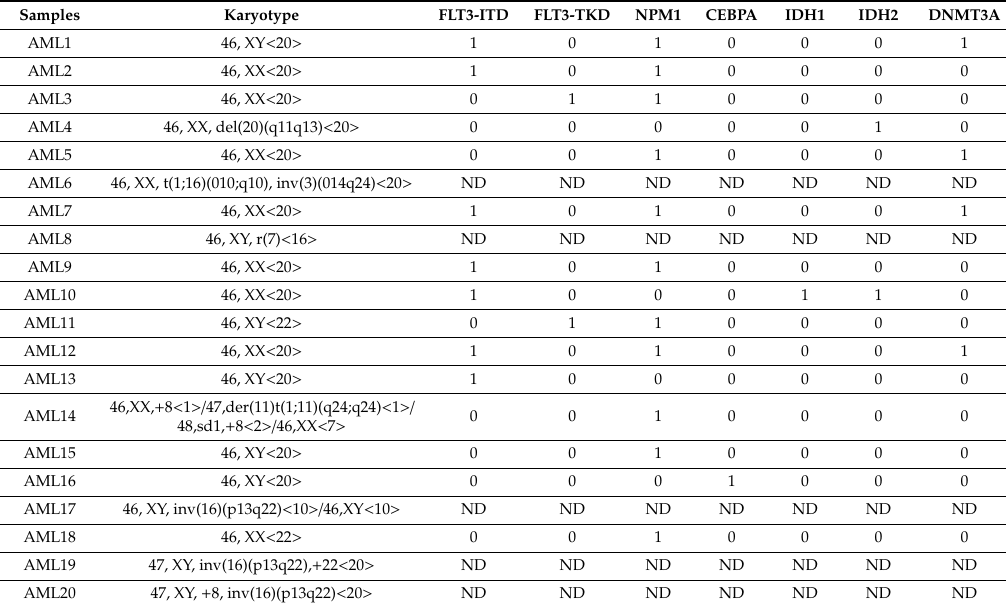
Table 1. Molecular and cytogenetic characteristics of primary acute myeloid leukemia (AML) cancer cells from 20